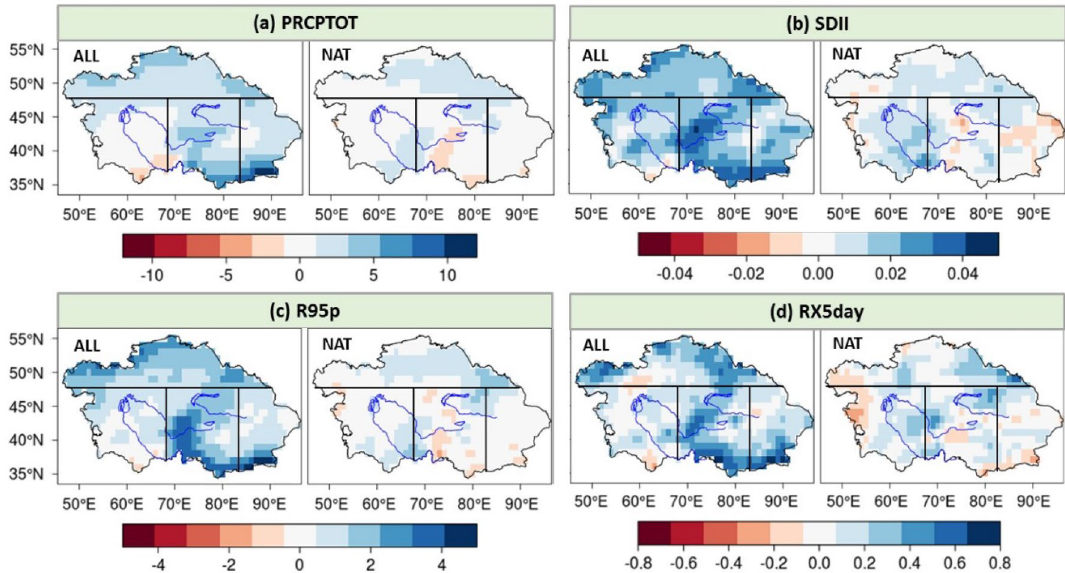
Figure 1. Spatial distribution of trends (ensemble means, mm/decade) for the PRCPTOT ( a ), SDII ( b ), R95p ( c ) and RX5day ( d ) under the CMIP5 ALL and NAT simulations during 1961–2005. The subfigures were done in the software R 4.0.2 (https:// cran.r- proje ct. org/ bin/ windo ws/), and then the subfigures were merged by using the Microsoft PowerPoint 2013 software (https:// www. micro soft.